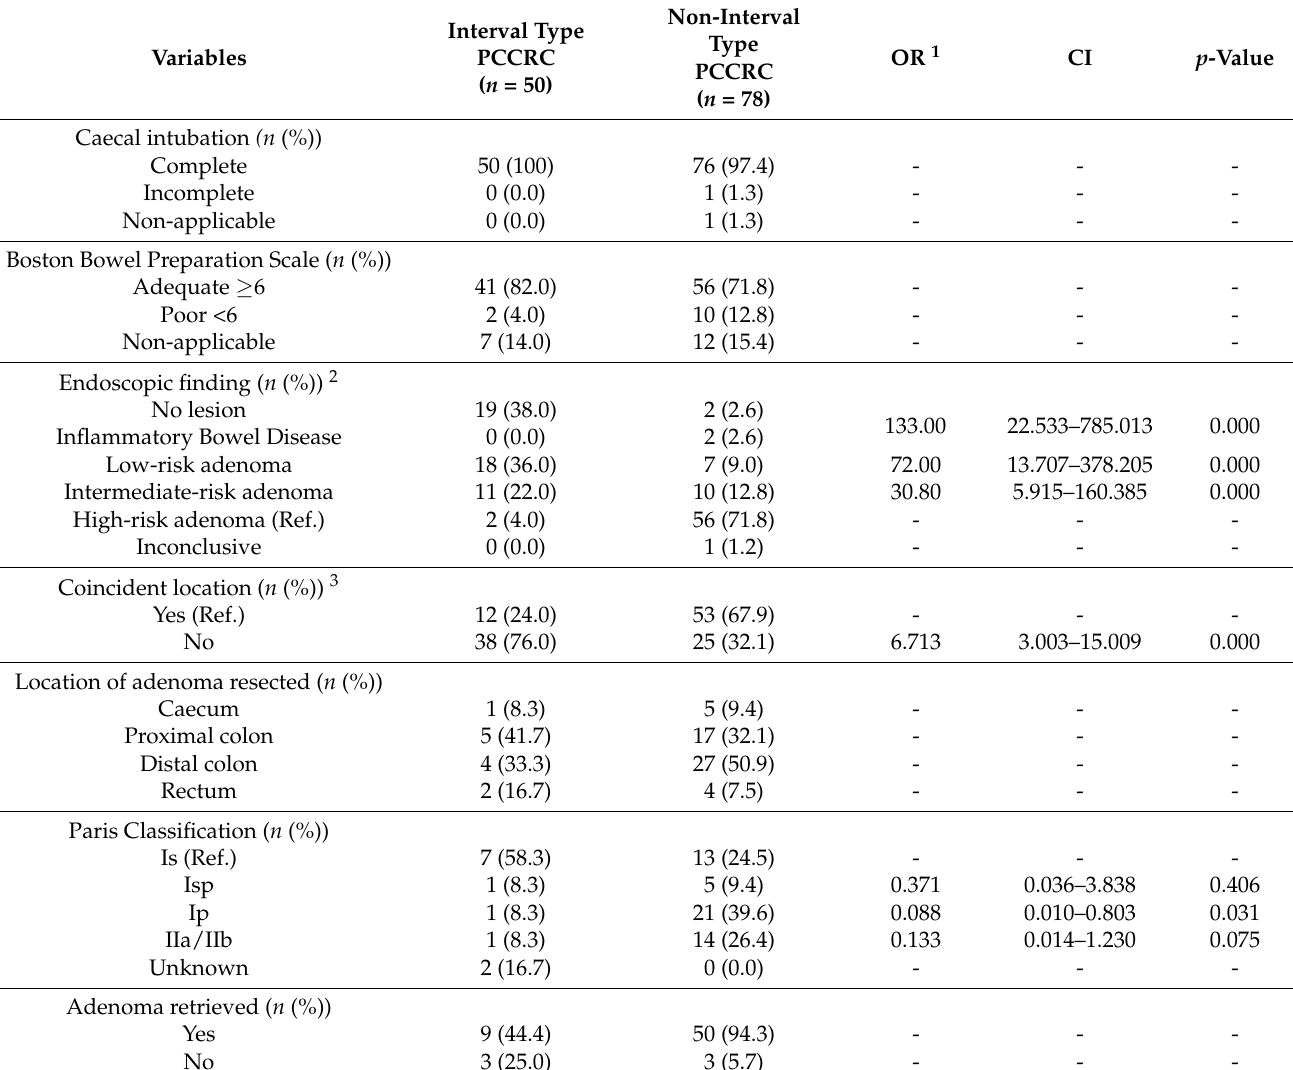
Table 3. Characteristics of the interval type PCCRC and non-interval type PCCRC in terms of the index